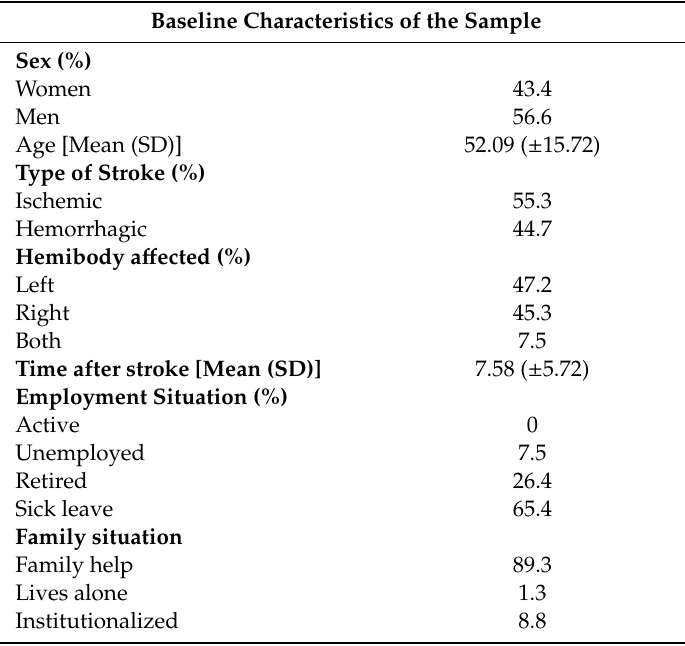
Table 1. Socio-demographics and clinical characteristics of the sample.